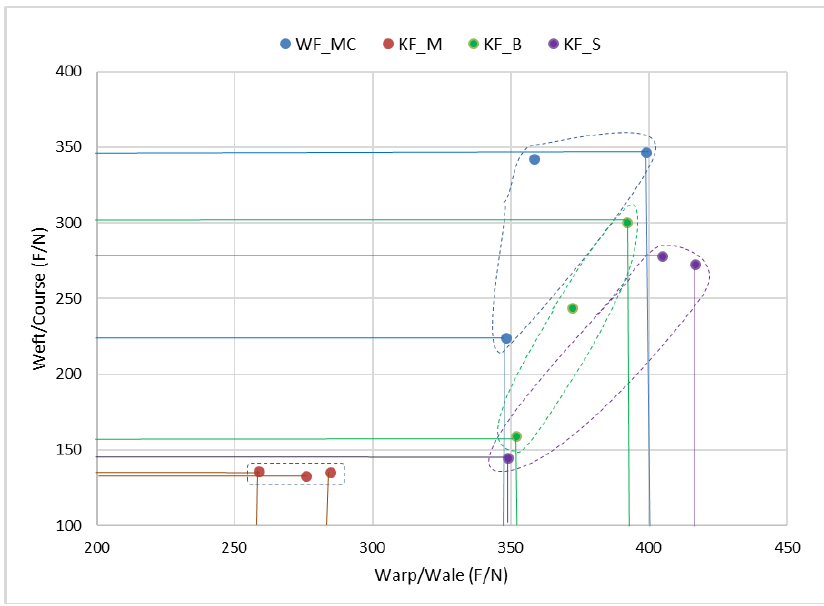
Figure 7. Relations of the breaking forces in the warp/wale and weft/course direction for each sample.